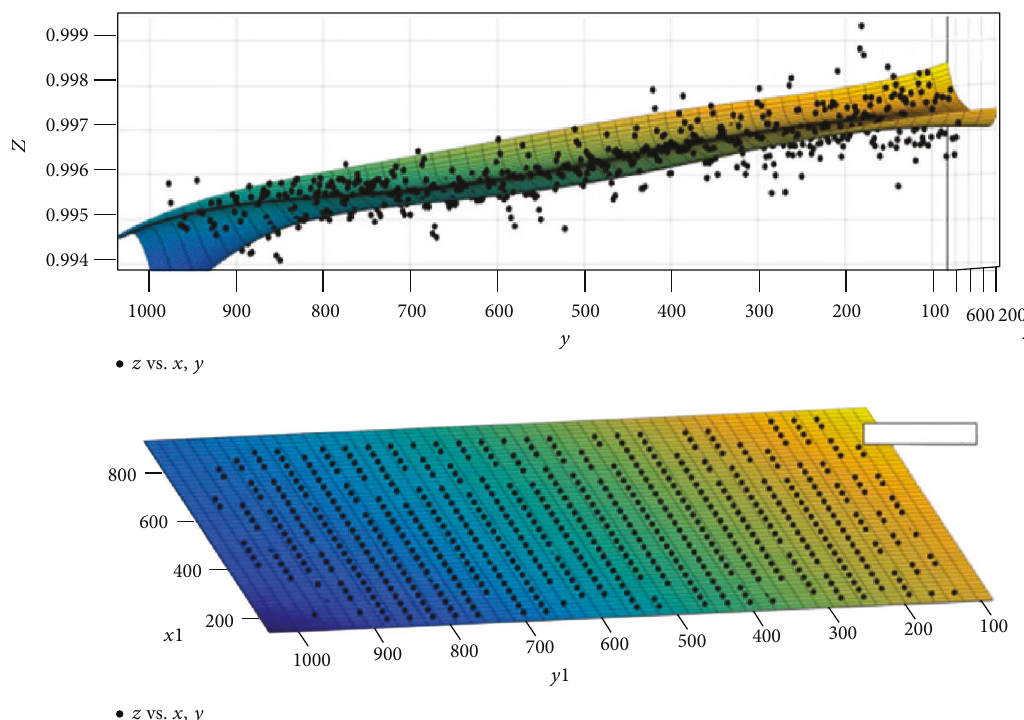
Figure 21: In this fi gure, we show the result of the minimum LAR surface optimization algorithm with a 1.2mm movement of the top of the plate (and a movement of about 0.3mm of the lower part of the plate). The upper part of the fi gure shows the surface from the ZY plane viewpoint, and the lower part shows the XY plane viewpoint.